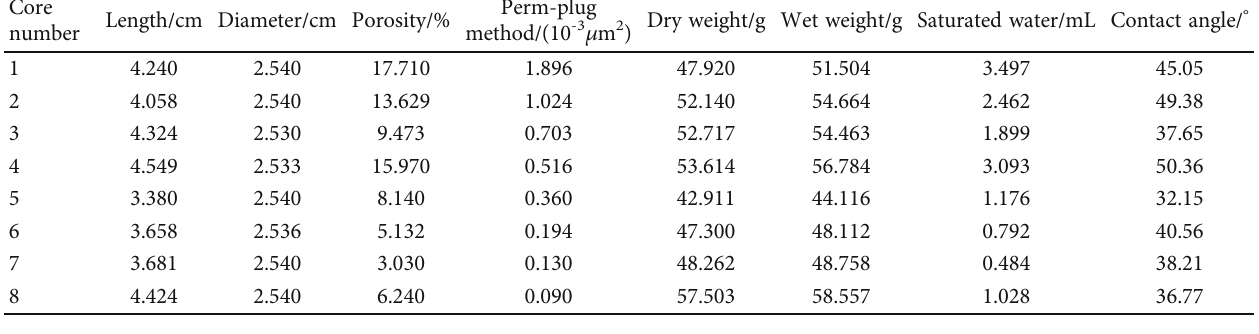
Table 1: Basic data of core used in gas – water permeability experiment.